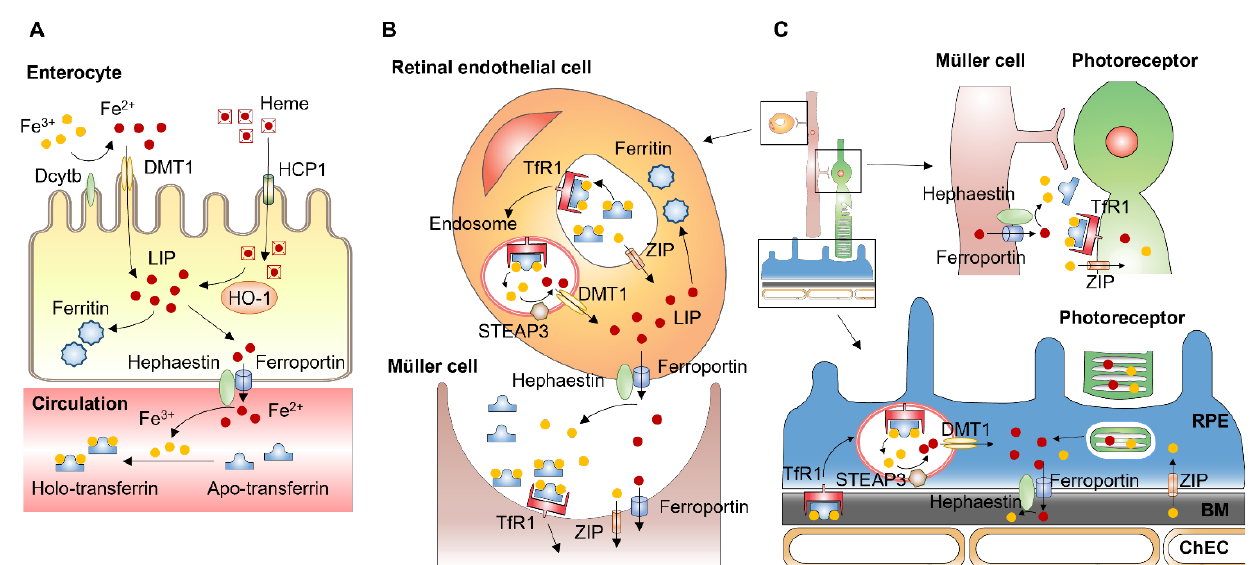
Figure 3. Systemic and local iron uptake and transport. ( A ) Enterocytes uptake dietary iron via divalent metal transporter-1 (DMT1) on the apical membrane. Iron uptake through DMT1 is mediated by duodenal cytochrome B (DCYTB), an enzyme that reduces Fe 3+ to Fe 2+ . Dietary heme is imported by heme carrier protein (HCP1) into enterocytes and degraded by heme oxygenase 1 (HO1) to release Fe 2+ . Iron transfer from enterocytes into the circulation is mediated by ferroportin located at the basolateral membrane of enterocytes. Ferroportin cooperates with ferroxidase hephaestin converting Fe 2+ to Fe 3+, which binds to transferrin in the circulation. ( B ) Retinal endothelial cells (EC) express transferrin receptor 1 (TfR1) at the apical membrane. After binding of iron-loaded transferrin, the TfR undergoes clathrin-mediated endocytosis. Within the endosome, Fe 3+ is released from transferrin and reduced to Fe 2+ by six-transmembrane epithelial antigen of prostate 3 (STEAP3). Fe 2+ is then transported from the endosome to cytosol by DMT1. Unbound Fe 3+ can be transported into retinal EC via Zinc transporters (ZIP) such as ZIP8 and ZIP14. Exported from retinal EC, iron is imported by glial cells such as Müller cells. ( C ) Exported by Müller cells, iron can be imported by photoreceptors expressing transferrin receptor, Zip8 and Zip14. Photoreceptors export iron via phagocytosis of shed photoreceptor outer segments by retinal pigment epithelium (RPE) cells. RPE cells also import iron from the choroid via transferrin receptor [66,67]. BM: Bruch’s